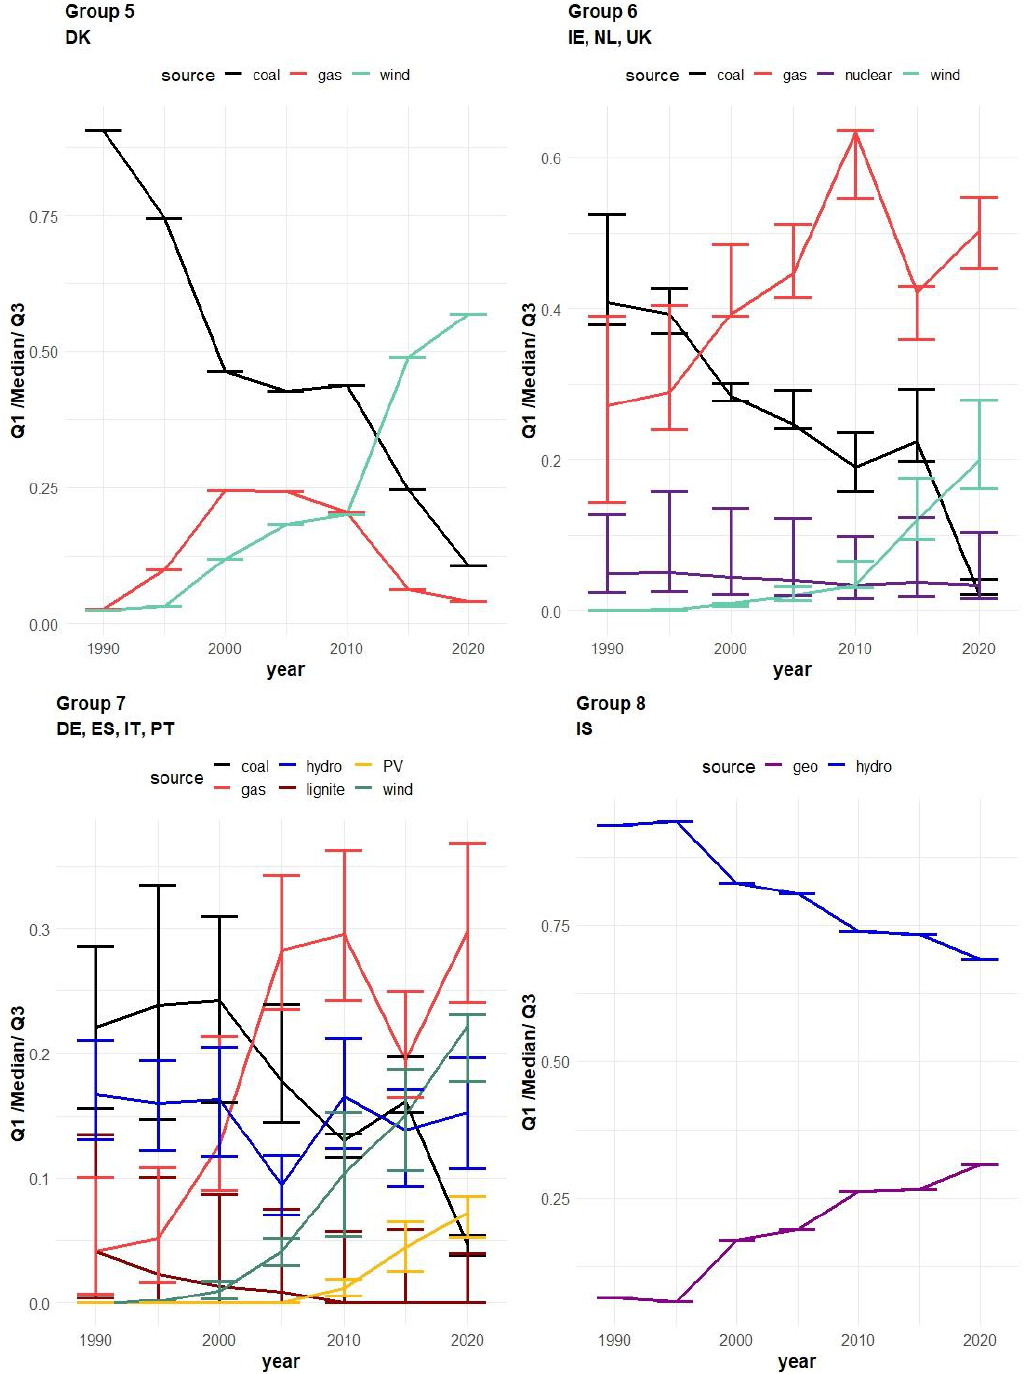
Figure 4. Changes in the structure of electricity production — clusters 5 – 8.